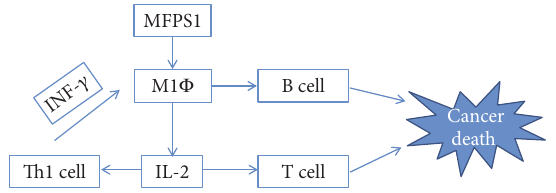
Figure 6: The speculated antitumor mechanism for the combination use of MFPS1 with